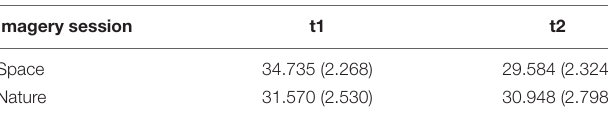
TABLE 1 | Means and standard errors (in parenthesis) from the weight estimation task as a function of time (t1 vs. t2) and type of imagery scenario (space vs.